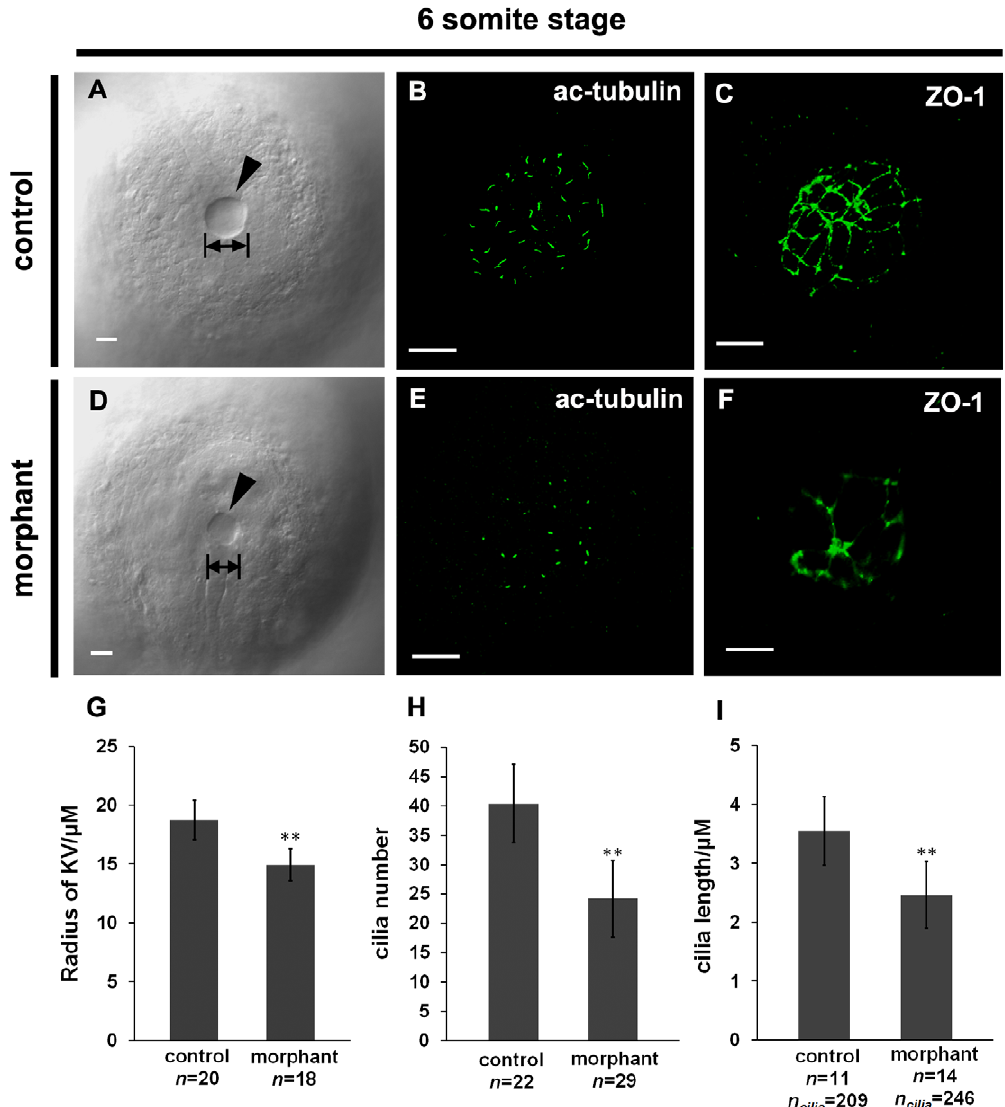
Figure 4. KV formation is disturbed in wdr18 morphant embryos. (A, D) DIC images of KV in control (A) and wdr18 morphant (D) embryos. Note the KV size in control was larger than that in the morphants. (B, E) Confocal images of cilia inside KV in control (B) and morphant (E) embryos detected by a fluorescent anti-acetylated tubulin antibody. Shown is a 3D projection of multiple focal slices spanning KV at an interval of 0.4 m m. (C, F) anti-ZO-1 staining of the KV in 6- to 8-somite stage embryos. The control embryo (C) developed a KV with a large fluid-filled lumen, showing a uniform ZO-1- positive tight junction lattice within the lining of the KV, while the wdr18 morphant embryo (F) showed a dysmorphic lattice of ZO-1 labeling within the KV. (G) Measurement of the radius of individual KV in control and morphant embryos at 6- to 8-somite stage and statistical analyses. (H) Graphic representation of quantification results of cilia number per KV in both control and morphant embryos at 6- to 8-somite stage. (I) Quantification result of cilia length in control and wdr18 morphant embryos at 6- to 8-somite stage. The double asterisks in G, H and I indicate that the difference is extremely significant between experimental and control samples ( P , 0.0001, Student’s t -test). Scale bars: 20 m m in A and D; 15 m m in B, C, E and F.